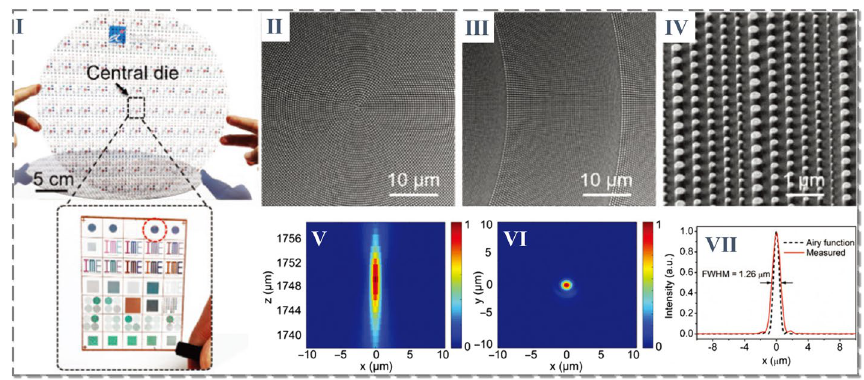
Fig. 13 Characterization of the meta-lens fabricated on a 12-in. glass wafer: (I) Color images of the fabricated 12-in. glass wafer and the central die in the wafer, with highlighted areas indicating the meta-lens. SEM images were obtained at the central (II), near-central (III), and outer zones (IV) of the meta-lens. Measured optical intensity of the meta-lens at the optical propagation plane (V) and the focal plane (VI). (VII) Horizontal cut of the focal spot is shown in (VI). Reproduced with permission [225]. Copyright 2020, published by